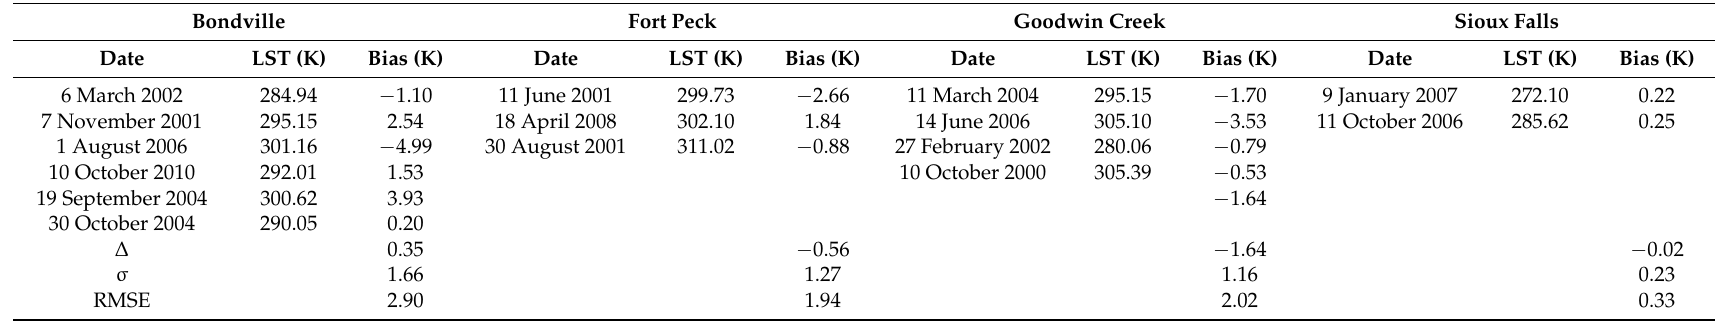
Table 10. Comparison of LST values derived from the SURFRAD stations and the LST inverted by the Planck function using band 14 of the ASTER instrument. Bondville Fort Peck Goodwin Creek Sioux